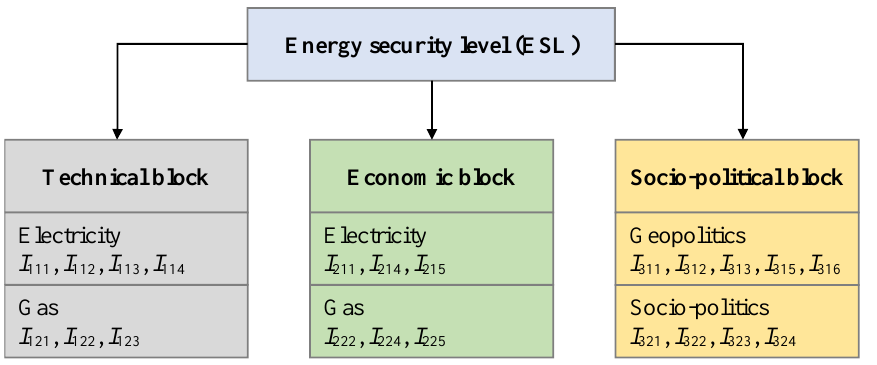
Figure 2. Composition of energy security level. Source: own research.